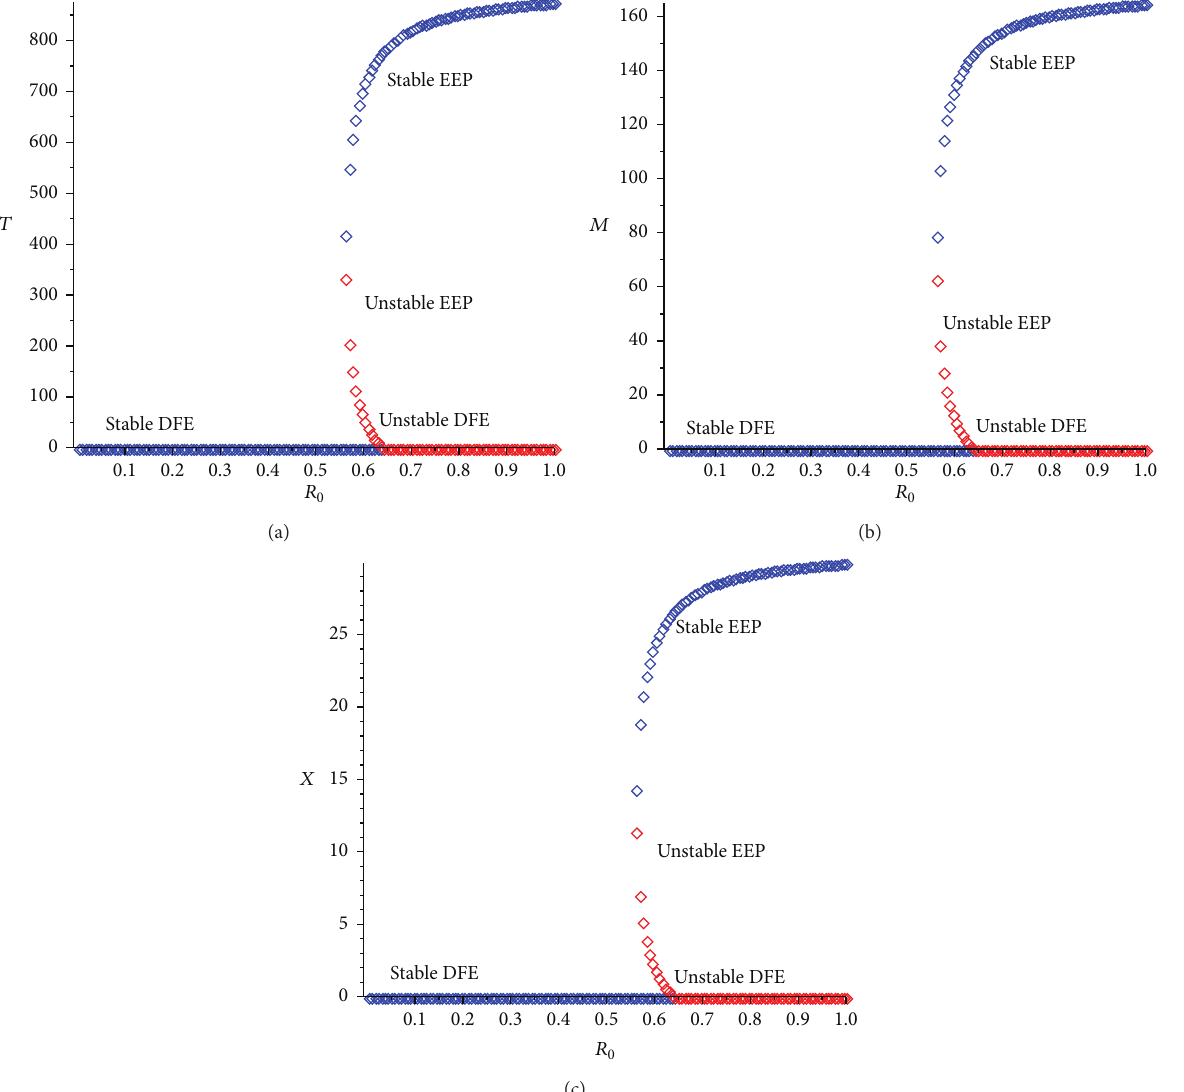
Figure 5: Backward bifurcation plot of model (2) as a function of time. (a) Individuals with drug sensitive TB ( 𝑇 ). (b) Individuals with MDR ( 𝑀 ). (c) Individuals with XDR ( 𝑋 ). Parameter values used are as given in Table